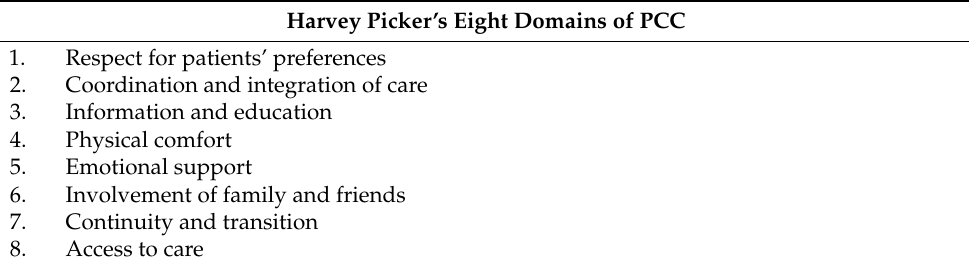
Table 1. The Picker Institute’s Principles of Patient-Centered